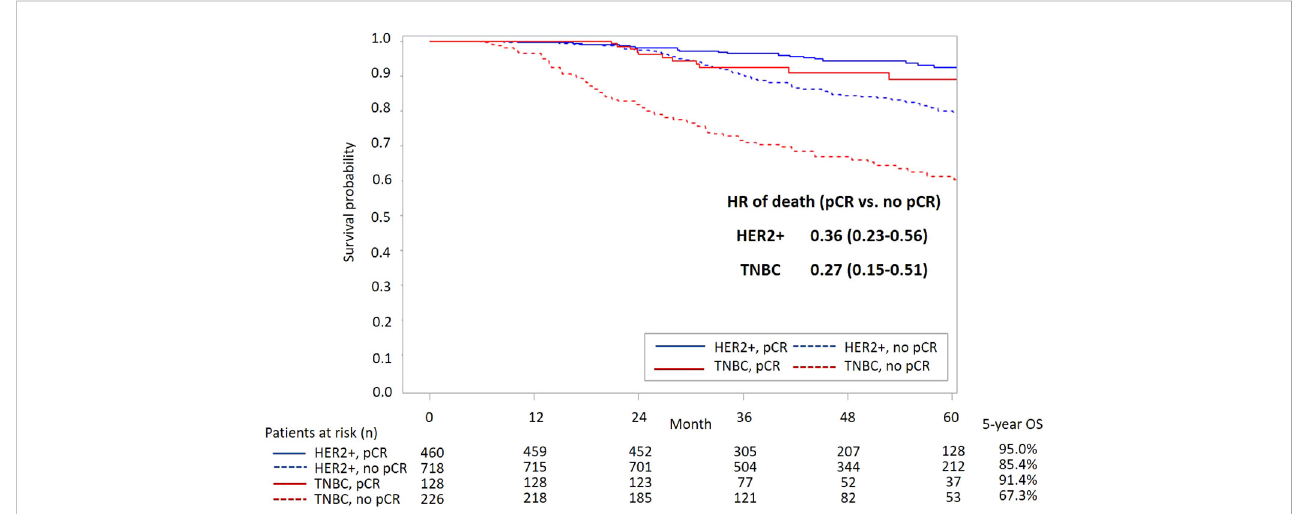
FIGURE 4 KM curves of OS strati fi ed by status of pCR and subtype. KM, Kaplan-Meier; OS, overall survival; pCR, pathological complete response; HR, hazard ratio; HER2, human epidermal growth factor receptor-2; TNBC, triple-negative breast